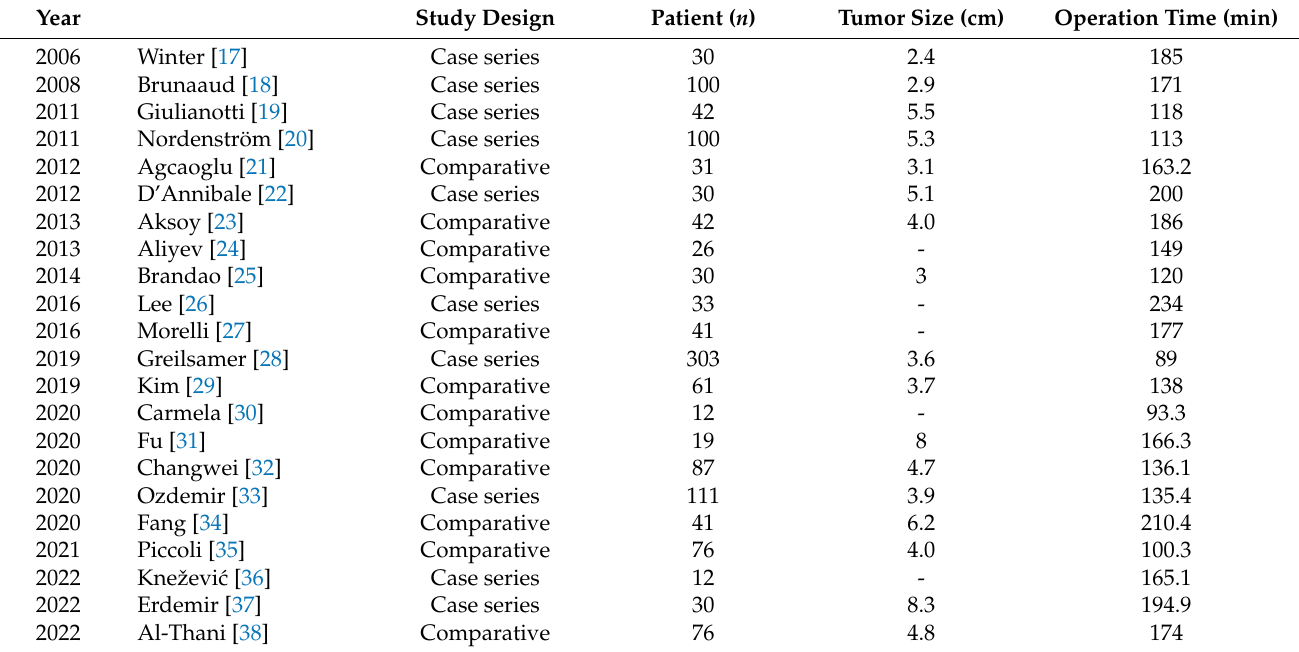
Table 3. Case series for robotic